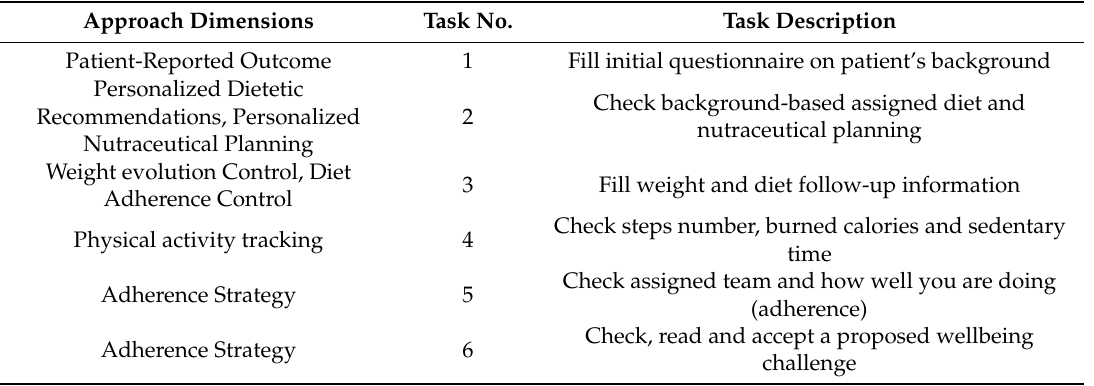
Table 2. Tasks tested by each person, defined within the usability testing protocol. Approach Dimensions Task No. Task